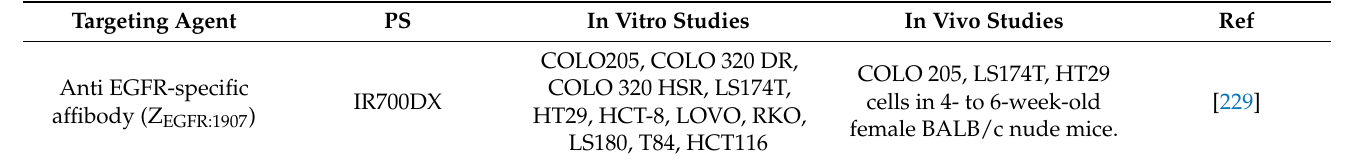
Table 12. EGFR-targeted PDT performed with anti-EGFR affibody.